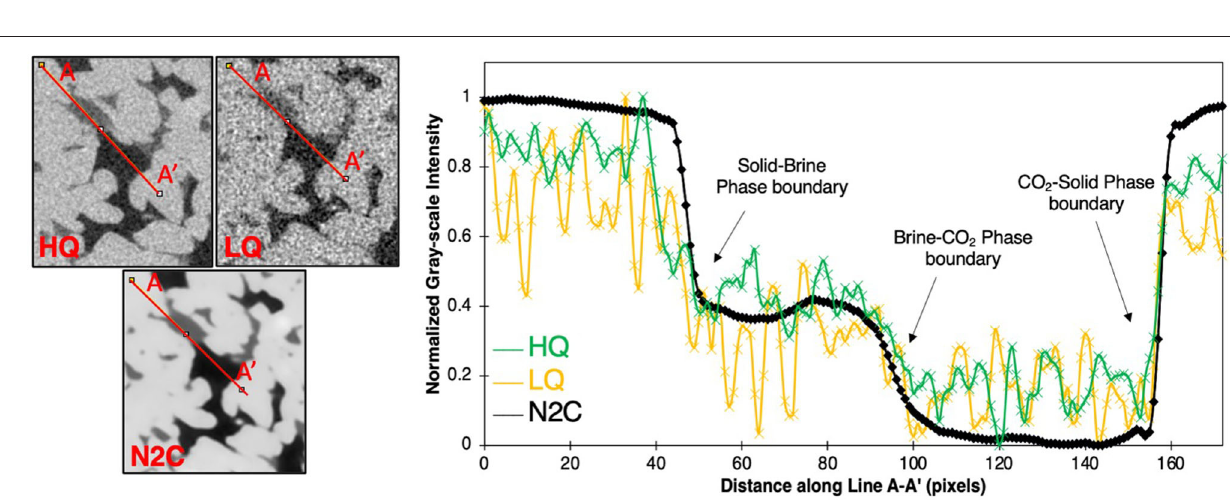
FIGURE 4 | (Left) Example cross-sections through the high quality (HQ), low quality (LQ) and Noise-to-Clean (N2C) datasets. (Right) Normalized gray-scale values along a line (A-A ′ ) passing through the solid, brine, and scCO 2 phases in the example cross sections. Slopes at the phase boundaries are indicative of phase boundary sharpness for the HQ, LQ, and N2C